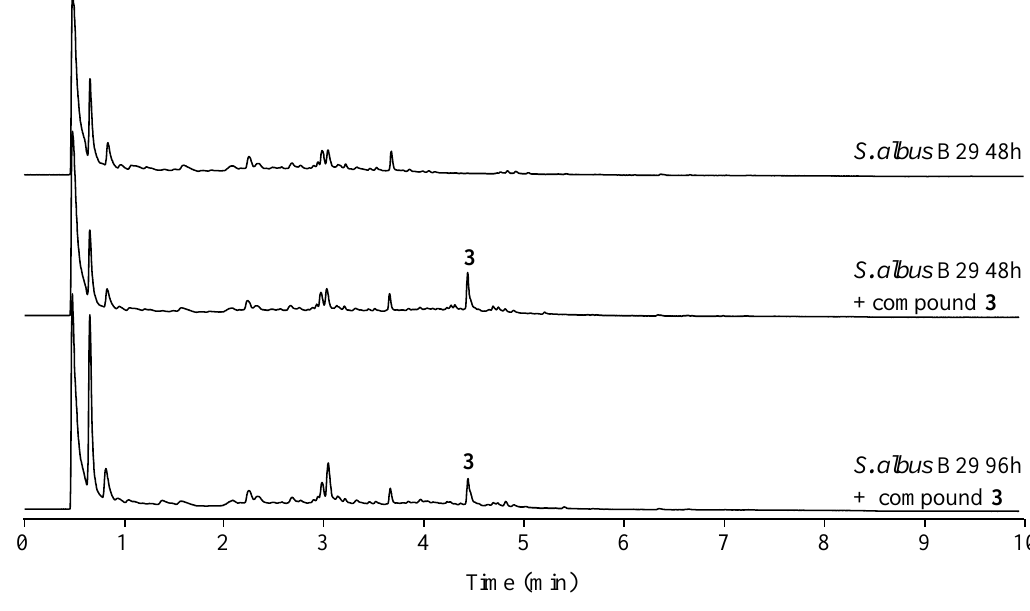
Figure 6. UPLC chromatograms, monitored at 238 nm, of mutant S. albus B29 grown in R5A liquid medium and fed with 50 μg mL −1 of compound 3 .